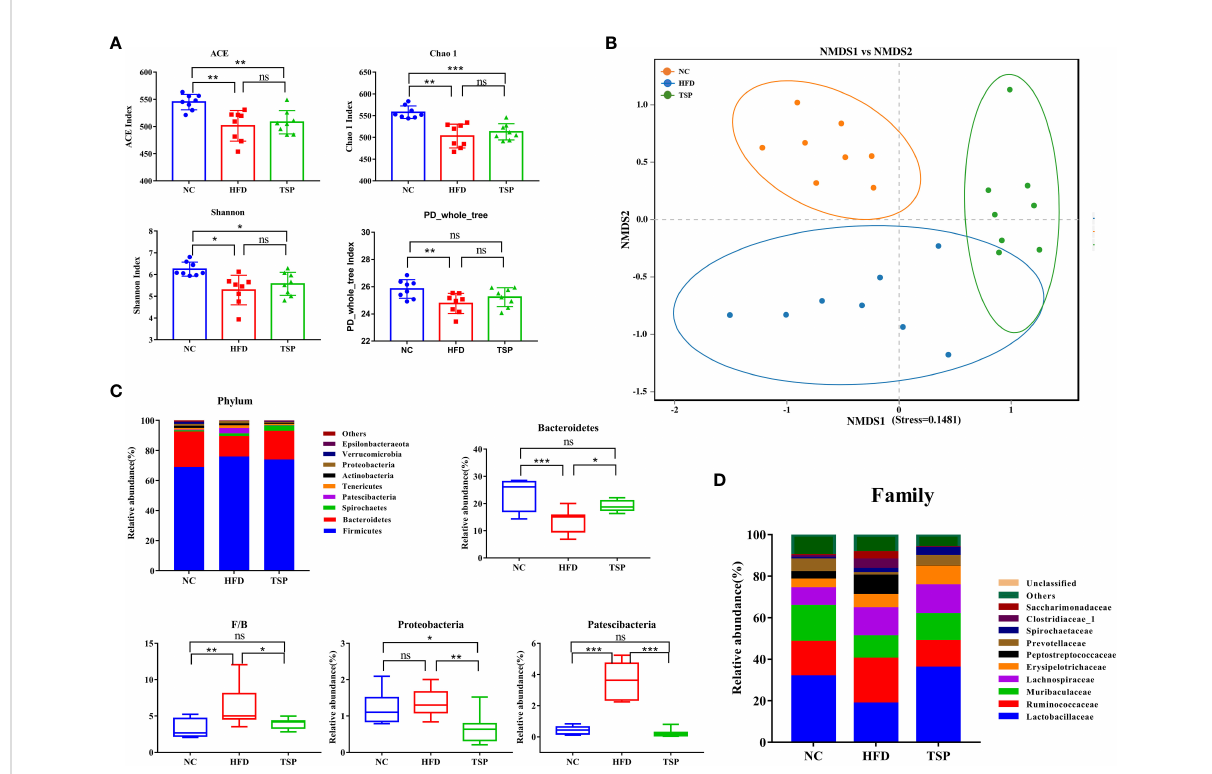
FIGURE 5 Effect of TSP supplementation on diversity and structure of the gut microbiota. (A) Alpha diversity analysis of ACE, Chao1, Shannon and PD- whole-tree index (B) Non-metric multidimensional scaling (NMDS) result based on Bray Curtis algorithm. (C) signi fi cantly changes ( p < 0.05) of the composition of the gut microbiota at phylum taxa level. (D) Changes of the composition of the gut microbiota at family taxa level. Data are expressed as mean ± SD, * p < 0.05, ** p < 0.01, and *** p < 0.001, ns, no signi fi cant p >